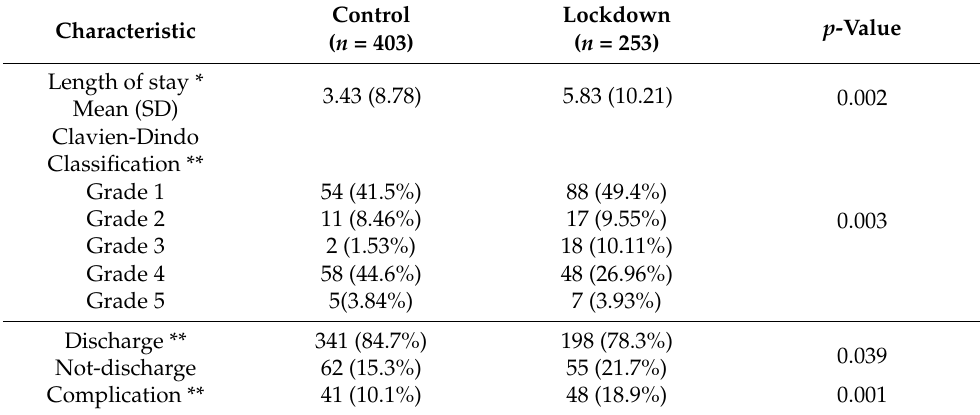
Table 3. Clinical and surgical consequences of patients during control and lockdown